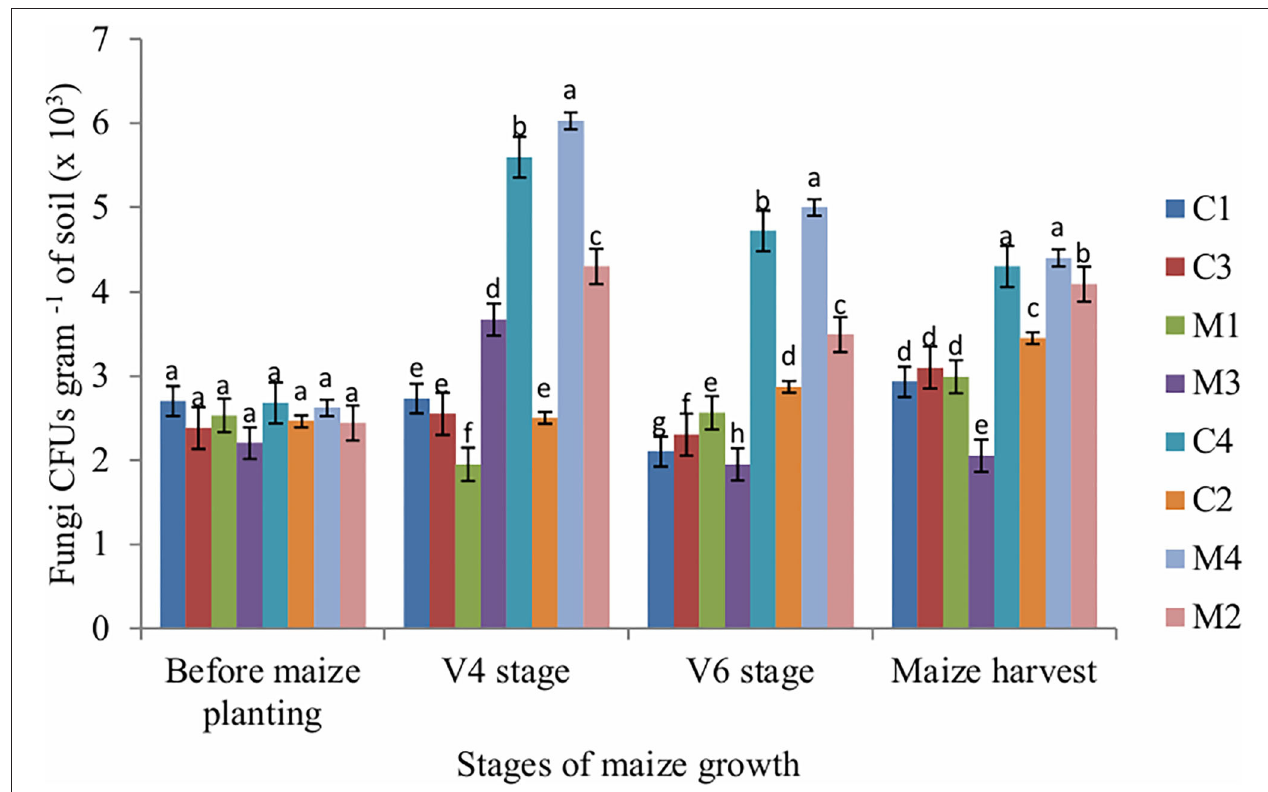
FIGURE 2 | Fungi CFUs as influenced by tillage, mulching and inorganic fertilization. Stages of maize growth were; before maize planting: 0 days, V4 stage: 22 days, V6 stage: 63 days, and maize harvest stage: 147 days. Vertical bars represent means and whiskers – standard errors.